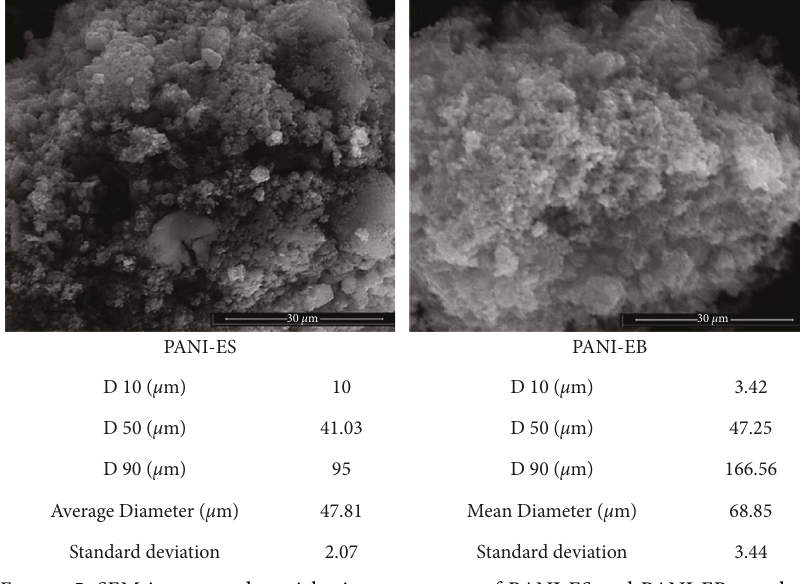
Figure 5: SEM images and particle size parameters of PANI-ES and PANI-EB powders.